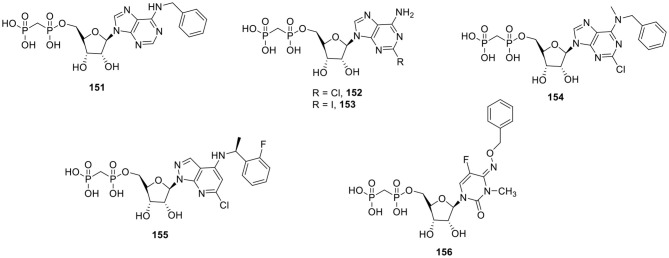
CD73 inhibitors.